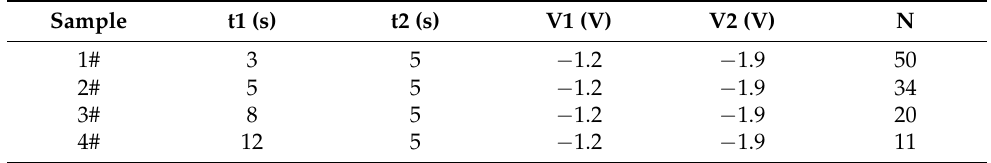
Table 1. Preparation parameters of Fe/Mn multilayer NWs arrays: Fe deposition voltage and time (V1, t1); Mn deposition voltage and time (V2, t2); number of repetitions